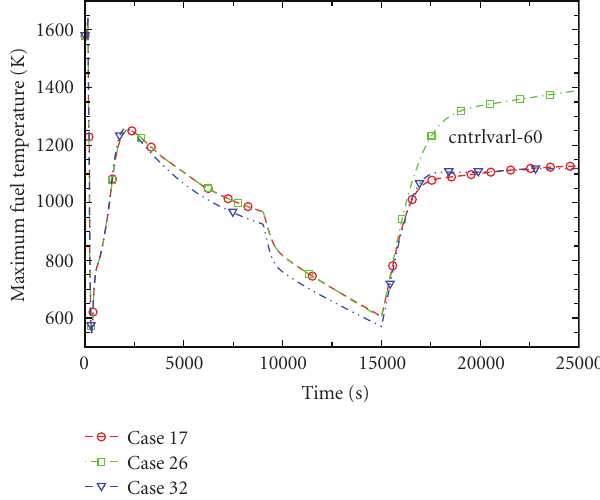
Figure 12: Peak fuel temperature core-wide.